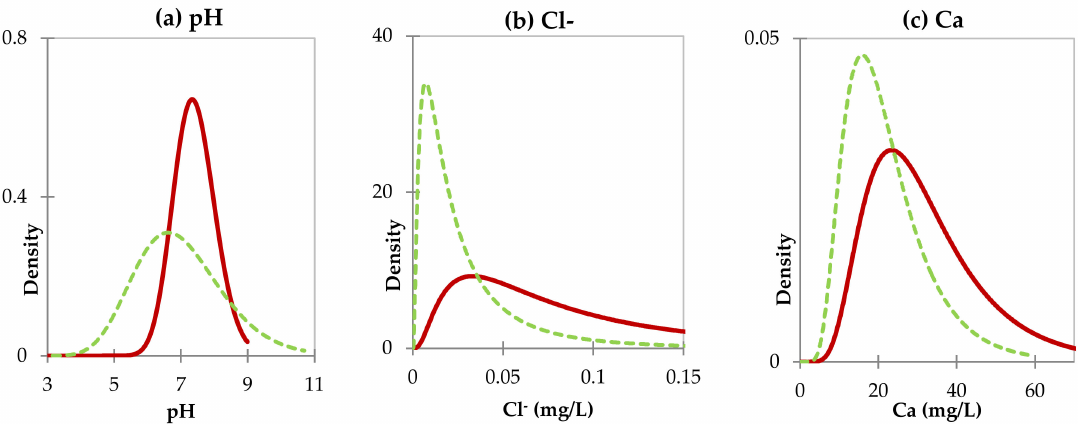
Figure 5. Log-normal probability distribution of ( a ) pH, ( b ) Cl − , and ( c ) Ca 2 + during the dry (red line) and wet seasons (green